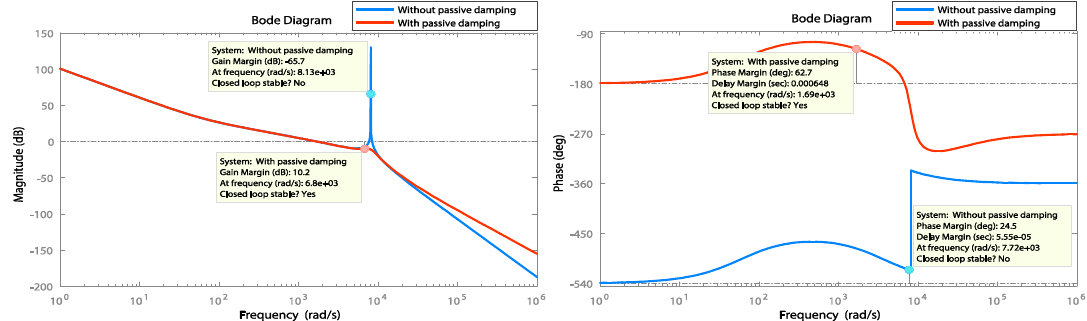
Figure 10. Quadrature grid current responses against a step change for different-tuned PI controllers.